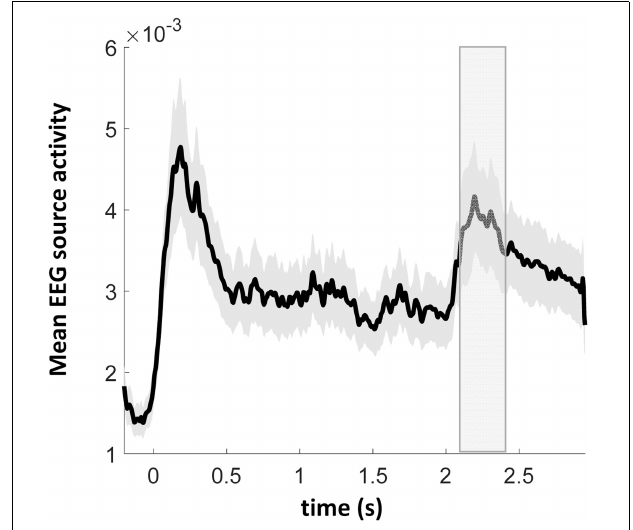
FIGURE 4 | Grand average EEG source activity (arbitrary unit, root sum square of three dipole moments of each source vertex) of 17 normal hearing participants. At the time points of 0, 0.5, 1, and 1.5 s the first four audiovisual adaptor stimuli were presented. At the time point of 2 s the probe sound-only stimulus was presented. The gray rectangle depicts the time window of interest in the cortical source analysis. Gray bounded lines indicate ±